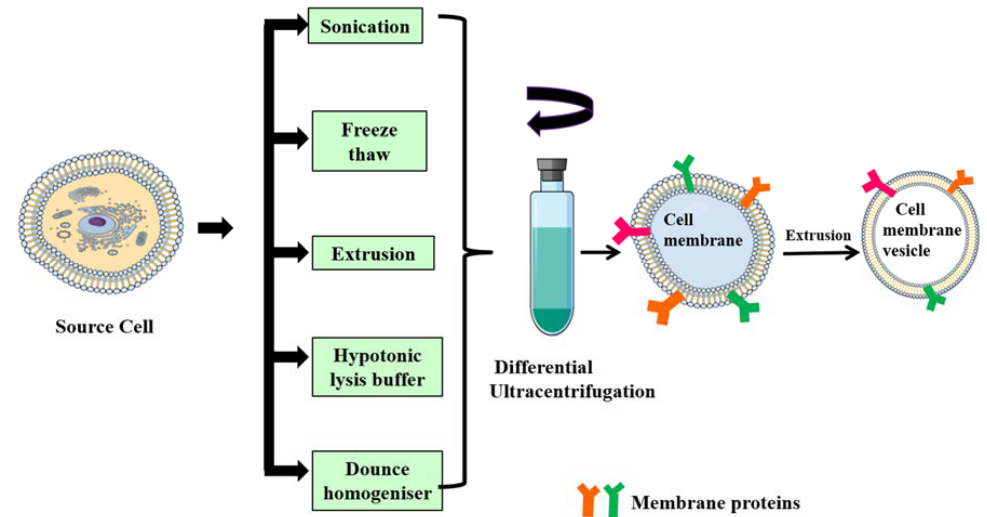
Figure 3. Schematic representation of different methods for isolation of the cell membrane from source cells. Membranes are isolated from source cells through different approaches such as sonication, freeze–thaw, extrusion, hypotonic lysis and dounce homogenizer, and are then subjected to a series of ultra ‐ centrifugations and extruded to obtain membrane